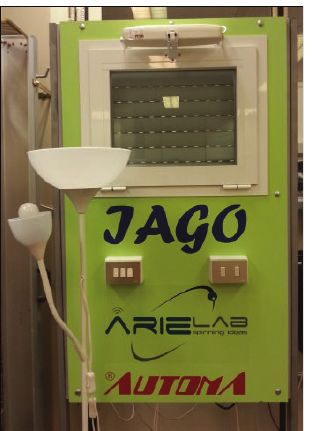
Figure 2: Demo panel of the home automation system selected for experimental purposes.